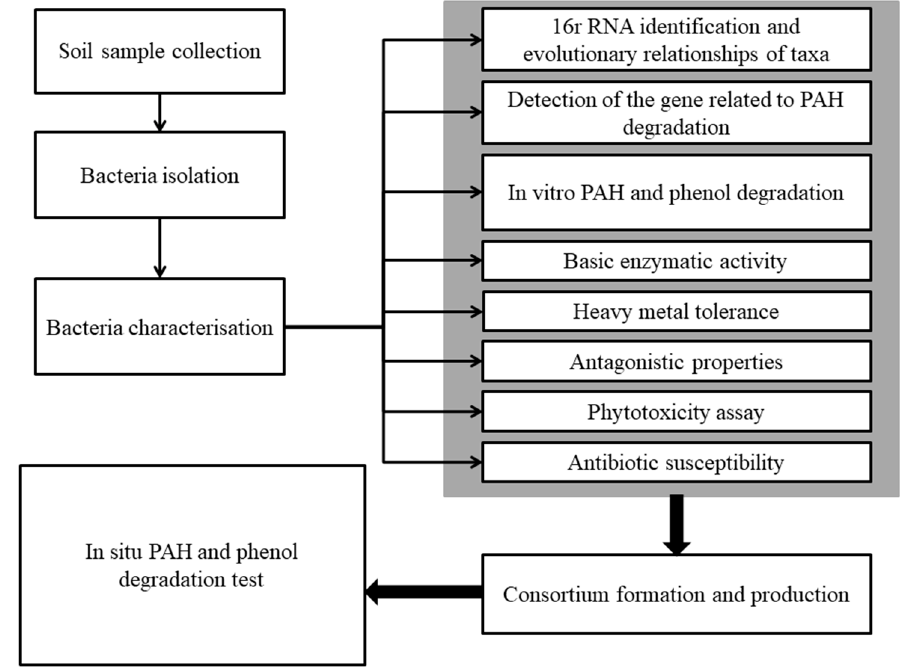
Figure 1. The design of the study.